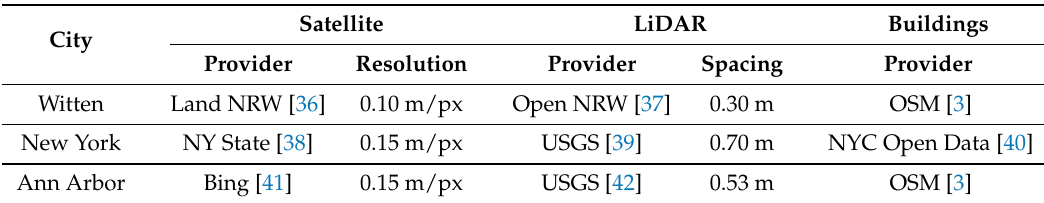
Table 3. Satellite, LiDAR, and building data sources.